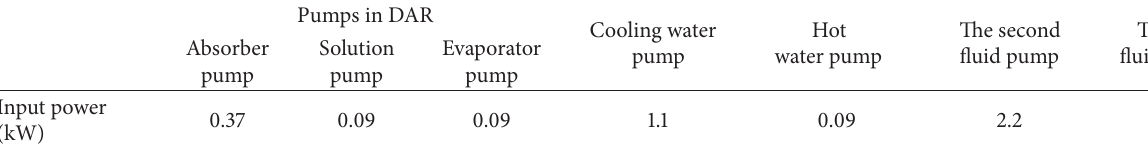
Table 2: Input power of each pump.